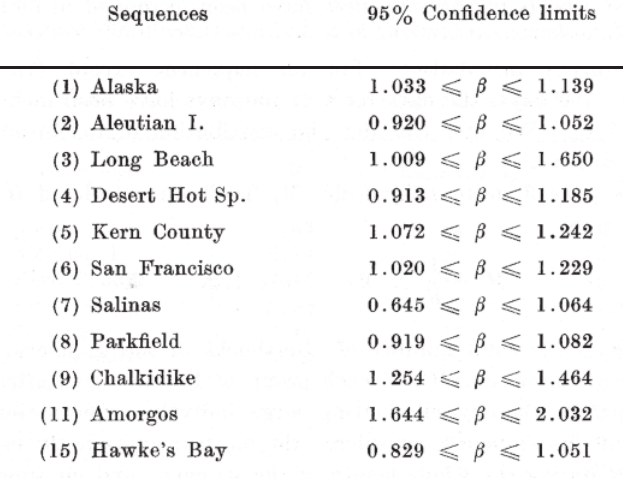
Table 6. Confidence limits on the decay